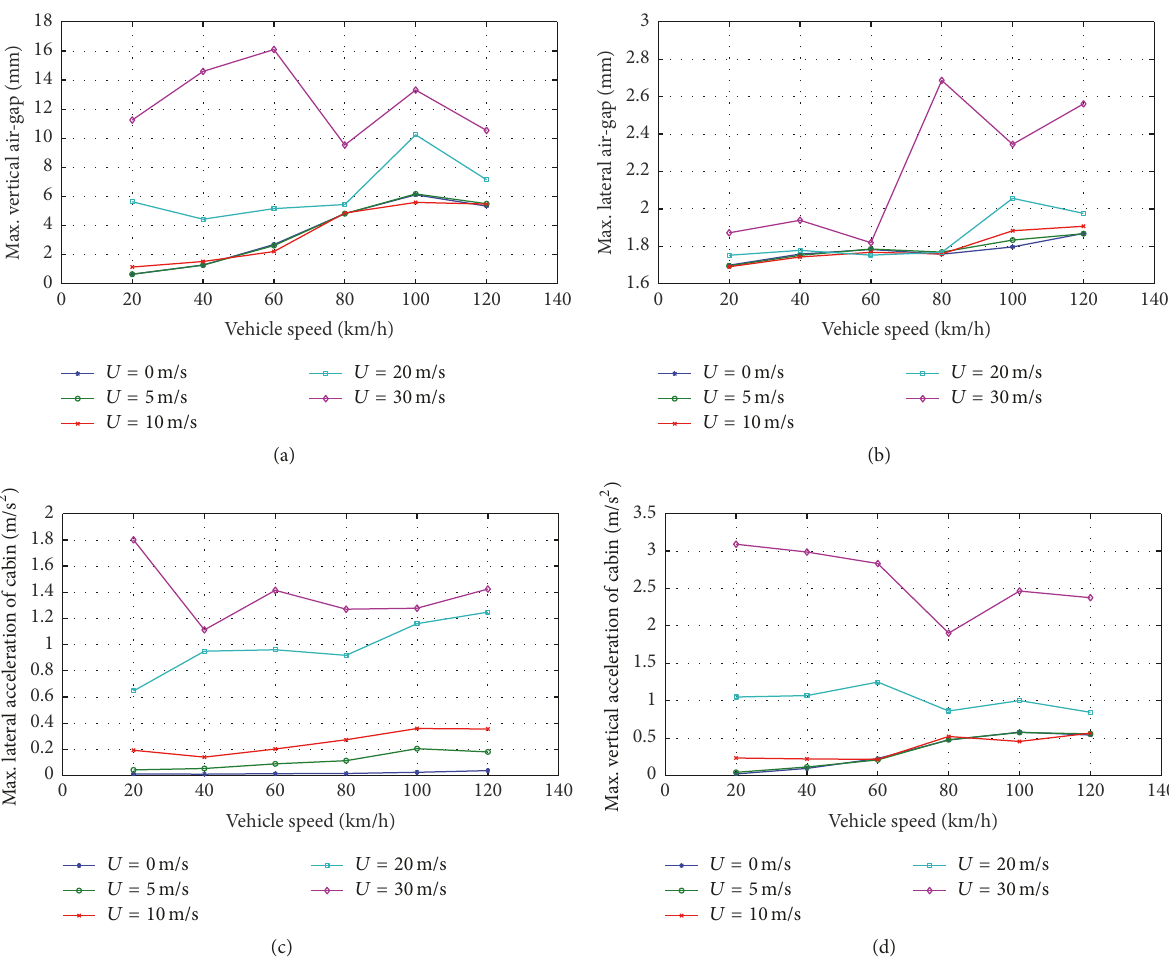
Figure 21: Maximum responses of the maglev vehicle under various wind velocity and vehicle speed: (a) vertical air-gap at 1st sensor, (b) lateral air-gap at 1st sensor, (c) vertical acceleration of cabin, and (d) lateral acceleration of cabin.